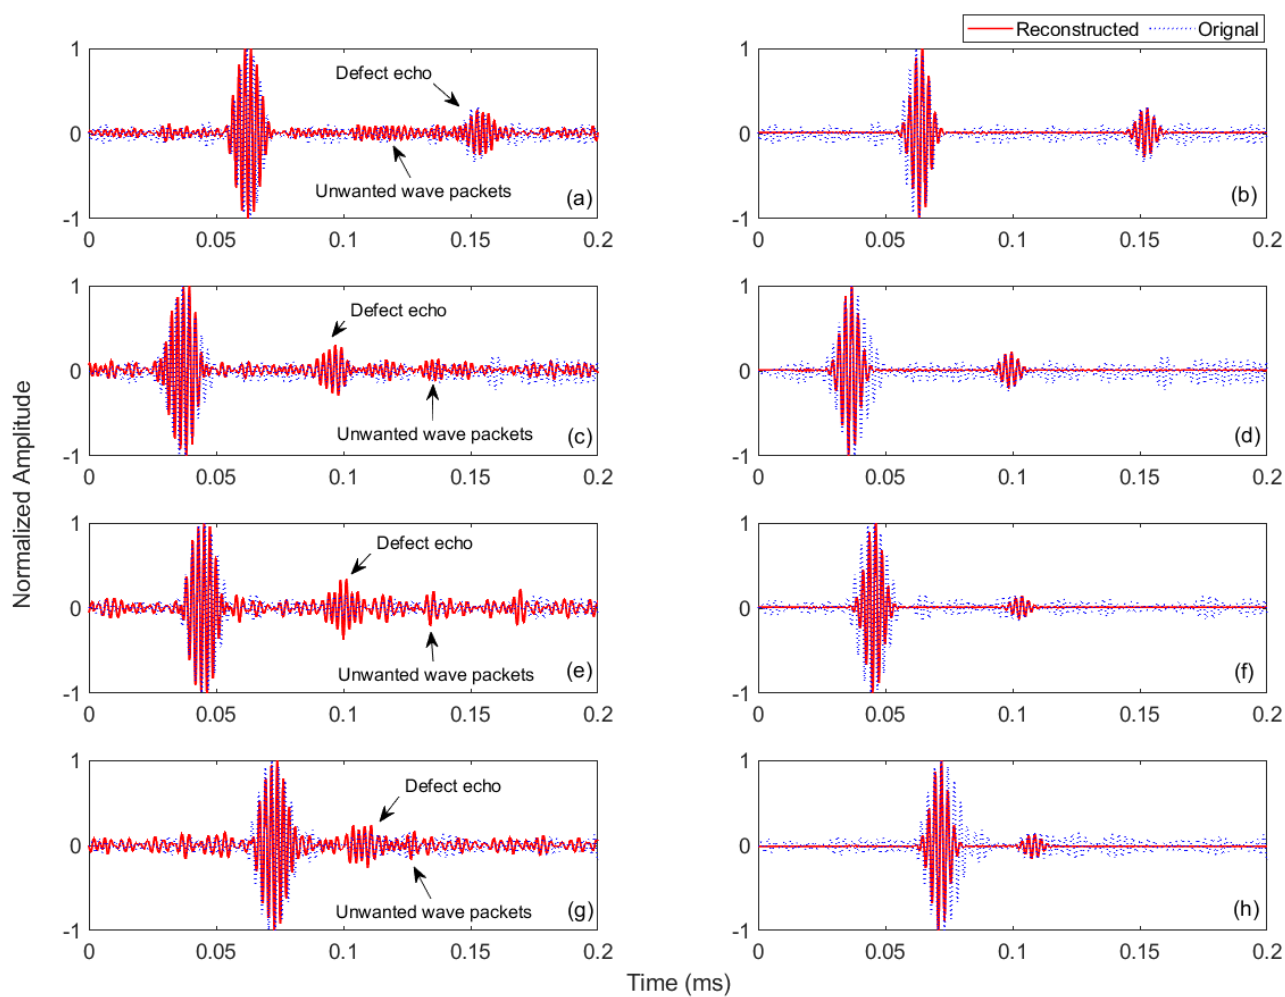
Figure 13. Original captured signals and their reconstructed signals after MP with the experimental dictionary: ( a ) specimen B with surface horizontal defect, ( c ) specimen C with surface edge defect, ( e ) specimen D with subsurface horizontal defect and ( g ) specimen E with subsurface vertical defect; and after MP with the FEM simulation dictionary: ( b ) specimen B with surface horizontal defect, ( d ) specimen C with surface edge defect, ( f ) specimen D with subsurface horizontal defect and ( h ) specimen E with subsurface vertical defect.